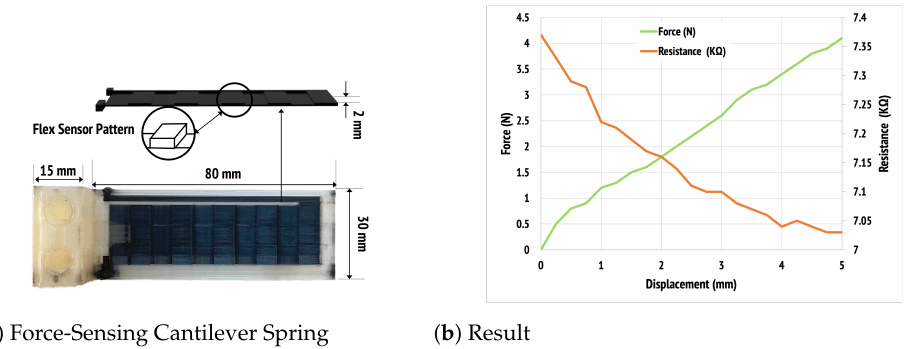
Figure 8. ( a ) 3D-printed force-sensing cantilever spring and the shape of embedded flex sensor, and ( b ) the results of force-displacement-resistance